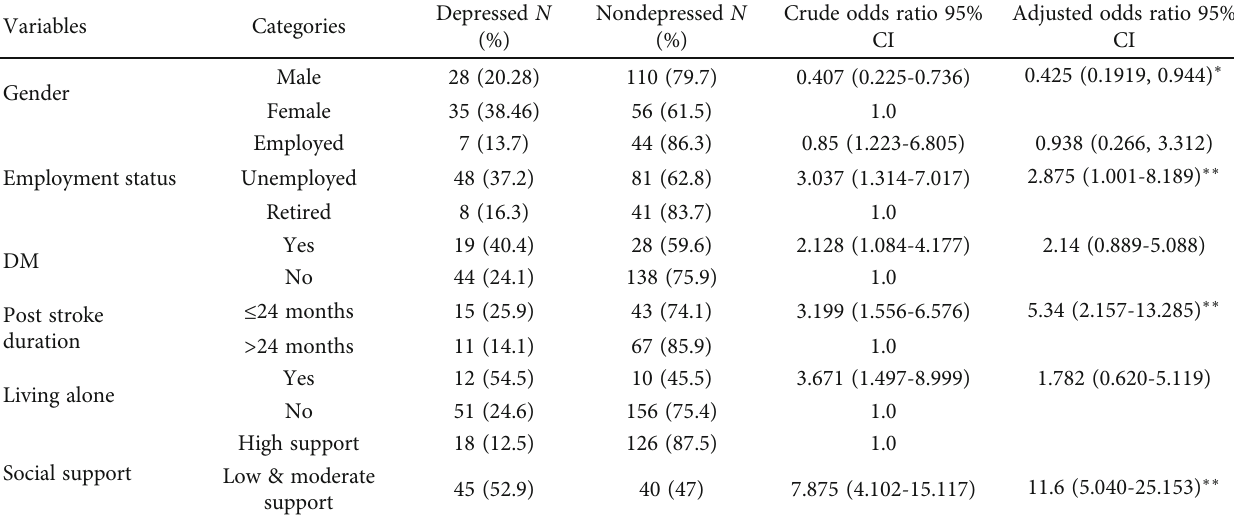
Table 3: Bivariate and multivariate logistic regression of factors associated with PSD at the outpatient neurology clinic of Zewditu Memorial Hospital in Addis Ababa, Ethiopia (total N = 229